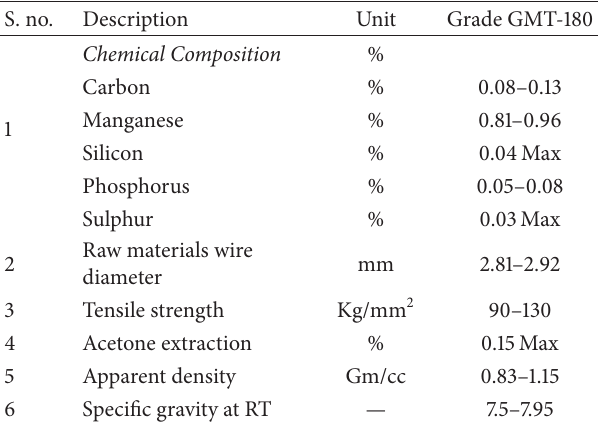
Table 1: Steel wool chemical composition and properties. S. no.